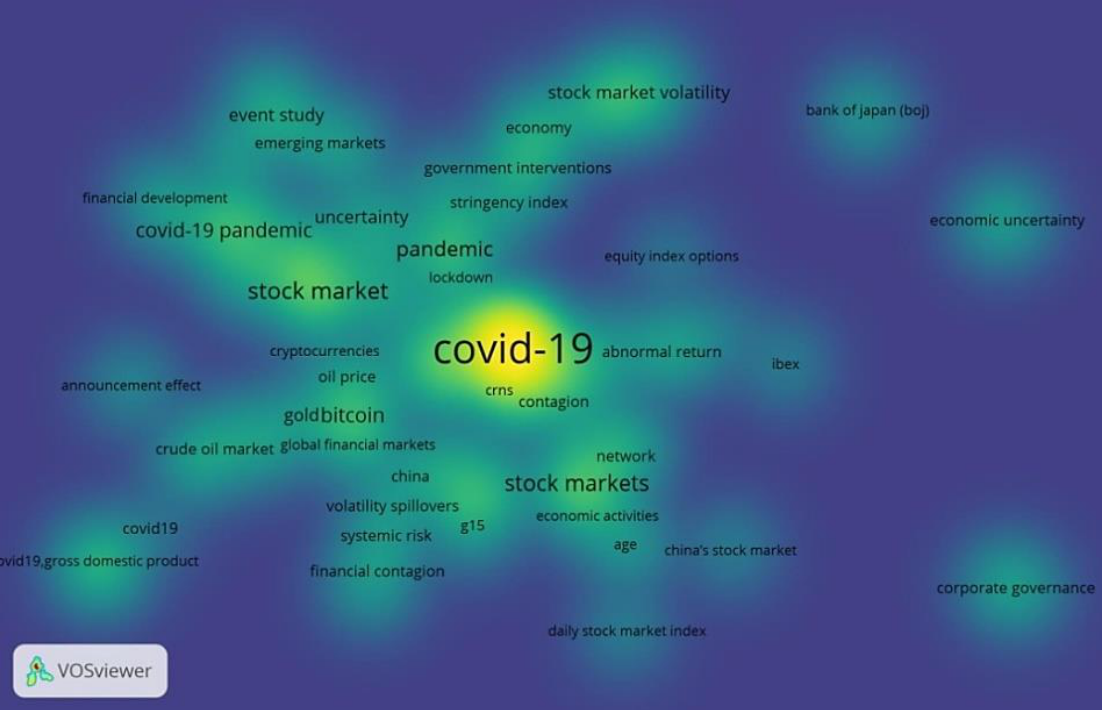
Figure 14. Item Density Visualization (Keywords)